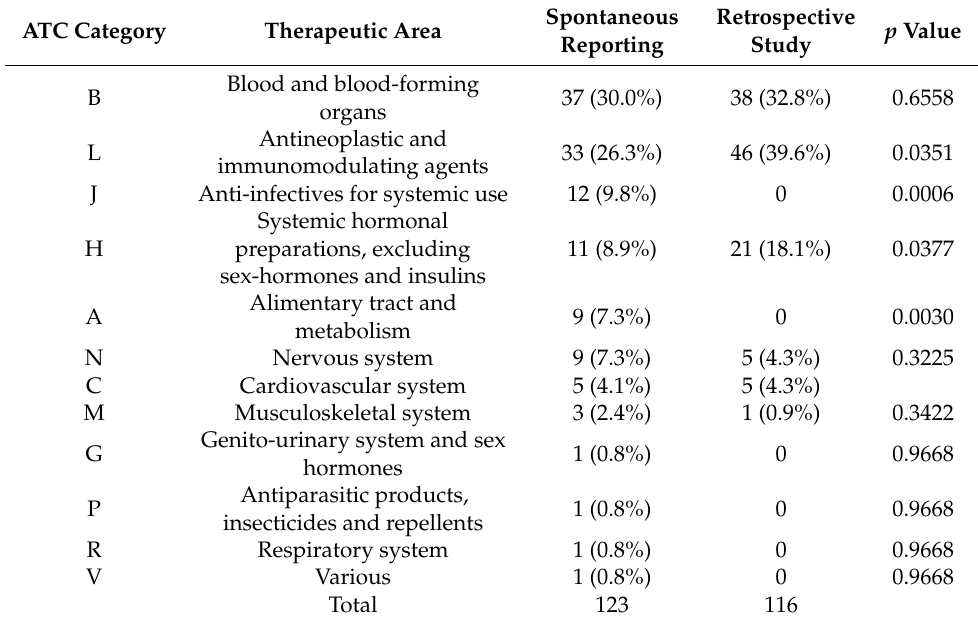
Table 11. Comparison of the ATC classification system of involved drugs.